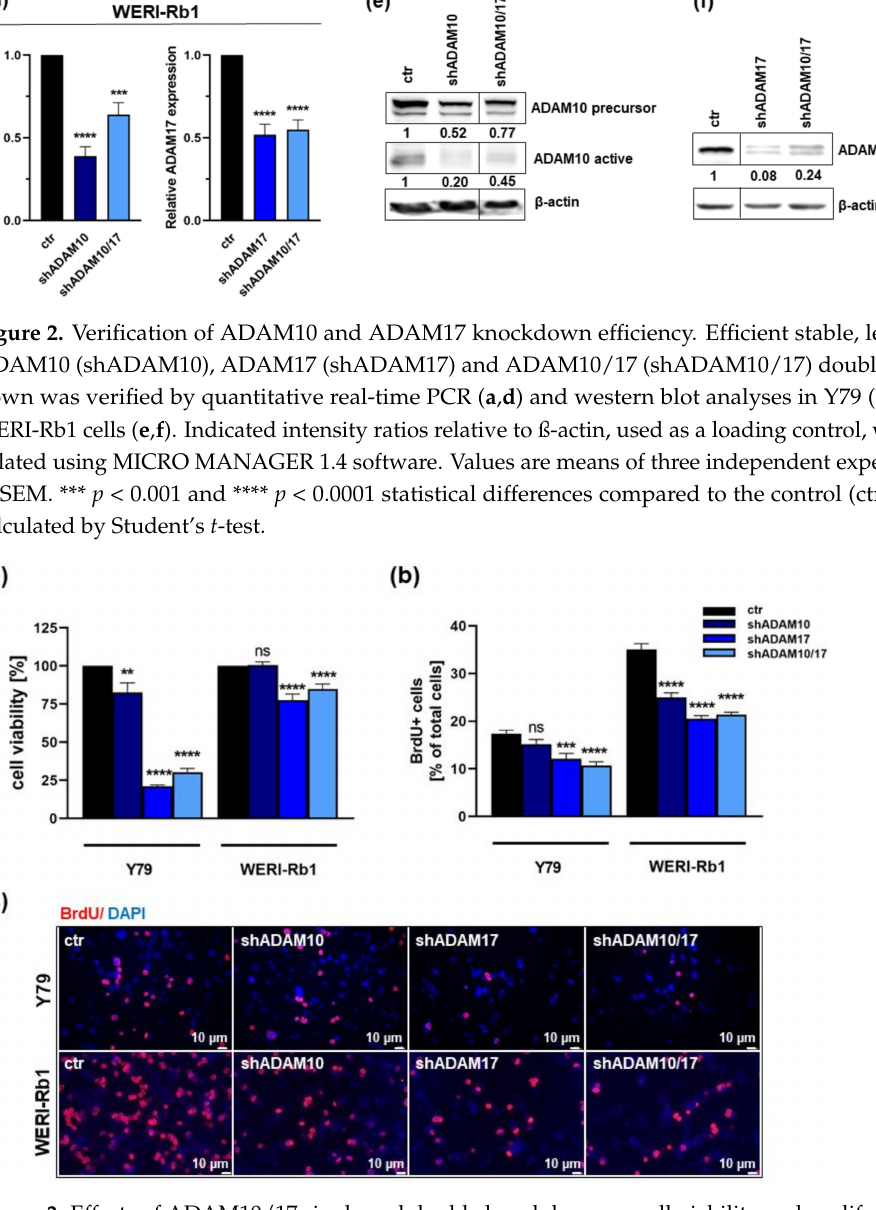
Figure 3. Effects of ADAM10/17 single and double knockdown on cell viability and proliferation of RB cells. Stable ADAM10 (shADAM10), ADAM17 (shADAM17) and ADAM10/17 (shADAM10/17) knockdown decreases cell viability and proliferation levels of Y79 and WERI-Rb1 cells compared to control cells (ctr) as revealed by WST-1 assays ( a ), and BrdU stains ( b , c ). Values are means of three independent experiments ± SEM. ns p > 0.05; ** p < 0.01; *** p < 0.001 and **** p < 0.0001 statistical differences compared to the control (ctr) group calculated by Student’s t